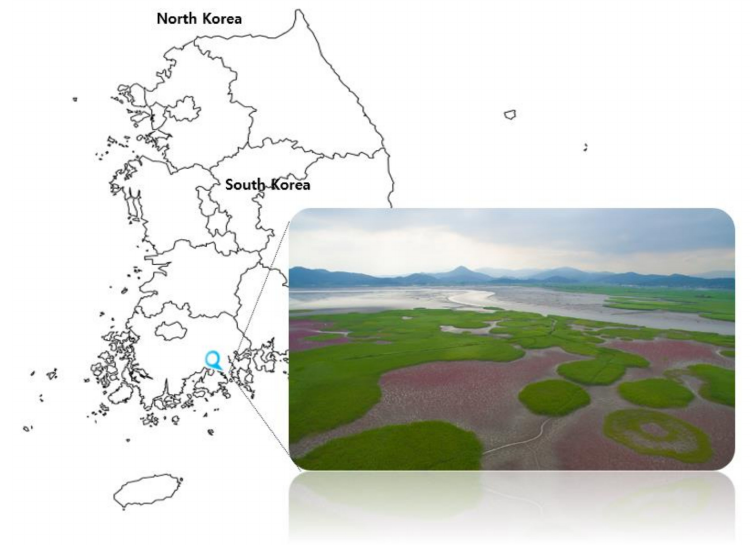
Figure 1. Location of Suncheon Bay and detailed view of the highly dominant status of two emersed halophyte species: Phragmites australis (green colony), Suaeda japonica (reddish-purple colony). Map was adapted from the Cultural Heritage Administration of Korea website [11], with permission from the Cultural Heritage Administration of Korea,